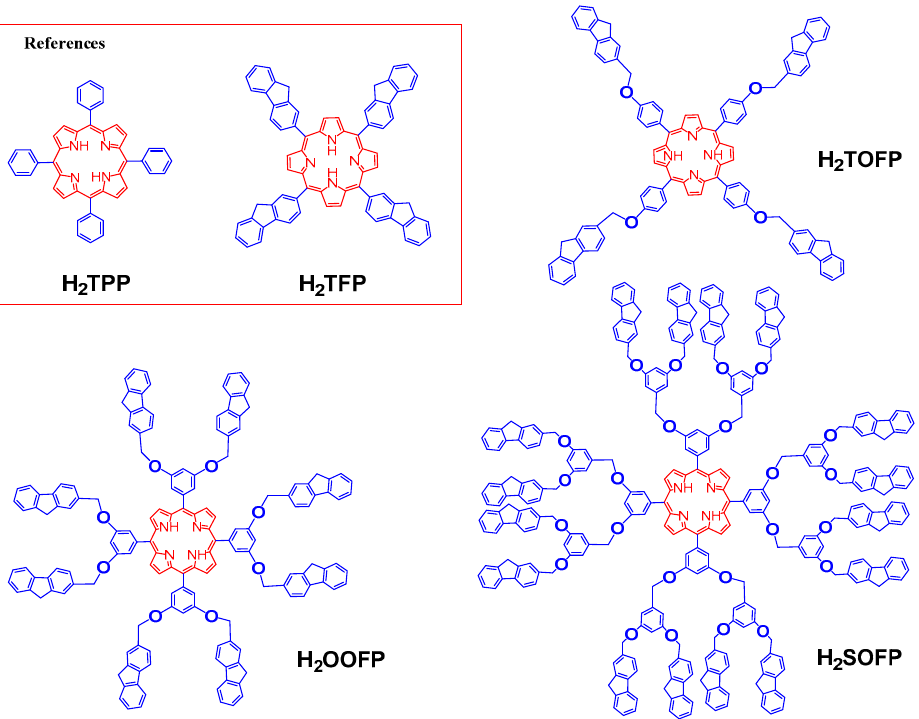
Figure 1. Series of porphyrin dendrimers previously studied and relevant reference compounds ( H 2 TPP (tetraphenylporphyrin) and H 2 TFP (tetrafluorenylporphyrin)).